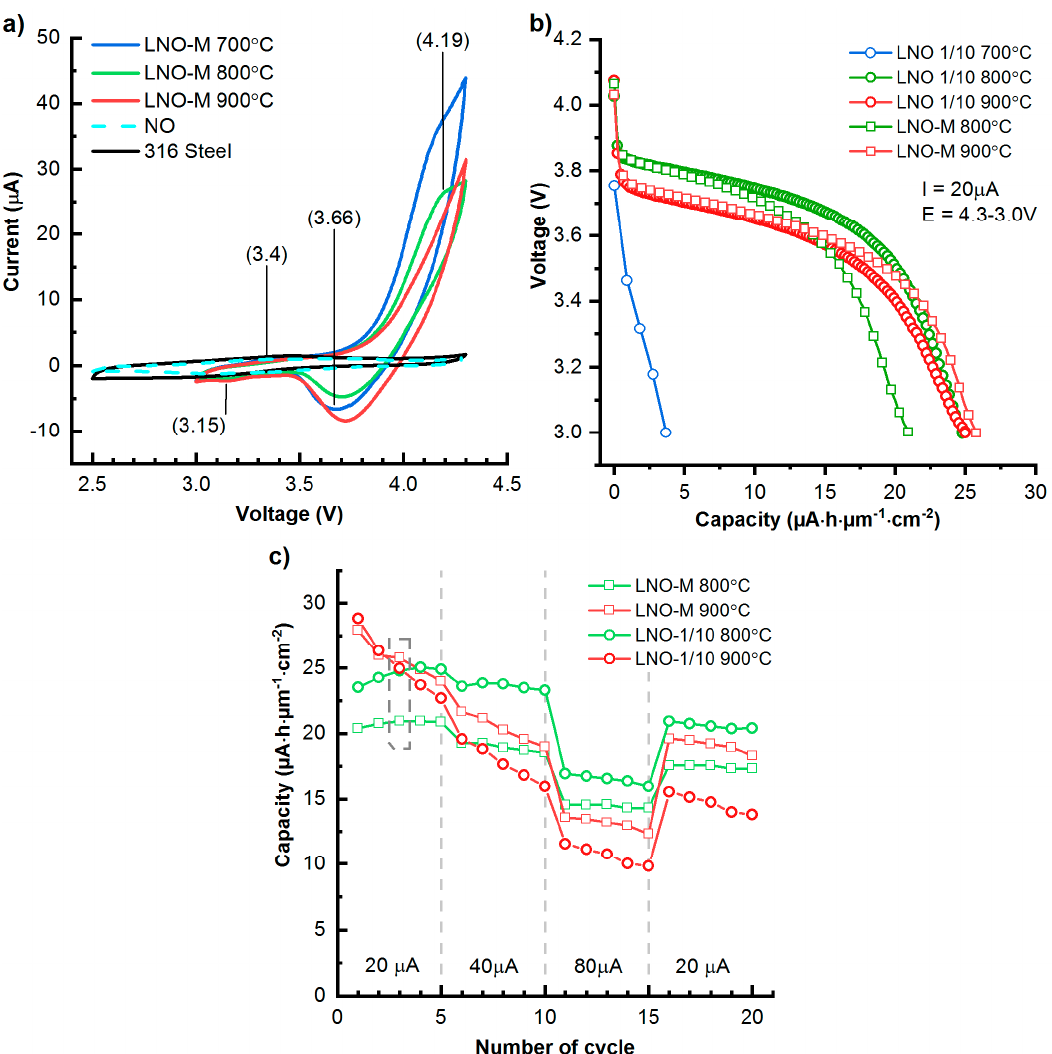
Figure 13. ( a ) Cyclic voltammograms of SS316 support, NO, and annealed LNO-M. The number of cycles is in parentheses, ( b ) discharge curves for the annealed LNO-M and LNO-1 / 10 samples, ( c ) rate performance of annealed LNO-M and LNO-1 / 10 samples. Discharge curves for points situated in dotted rectangle are presented in Figure 13b.